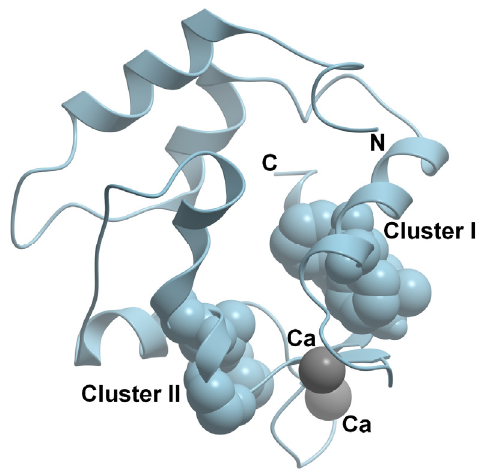
Figure 3. Ribbon model of the 3D-structure of rat parvalbumin (oncomodulin) (PDB code 1rro) with two bound calcium ions. Clusters I (‘black’) and II (‘gray’) are shown.